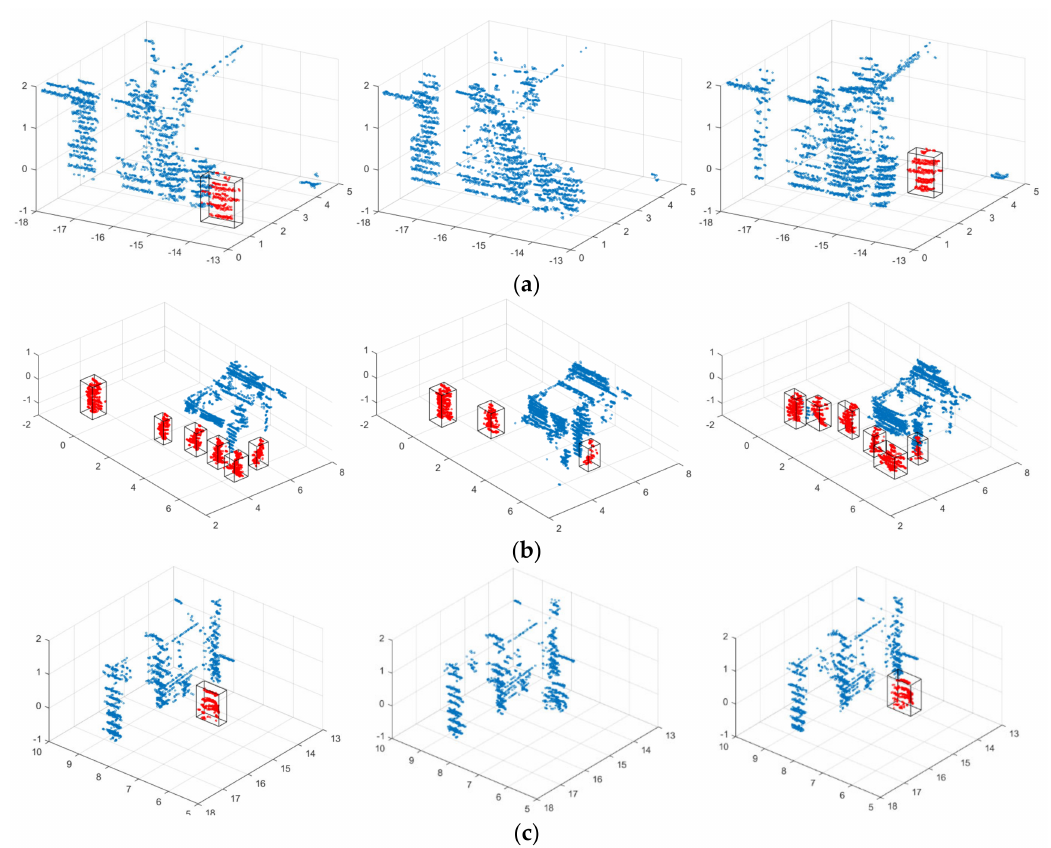
Figure 7. Examples of missing detection of pedestrians: ( a ) an unsegmented pedestrian; ( b ) some partially scanned pedestrians; ( c ) a mismatched pedestrian.